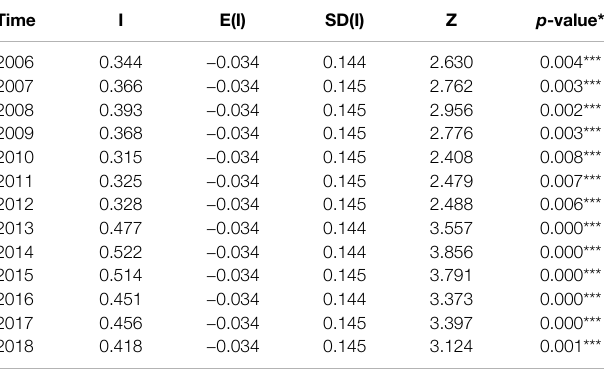
TABLE 2 | Moran ’ s I for haze pollution.